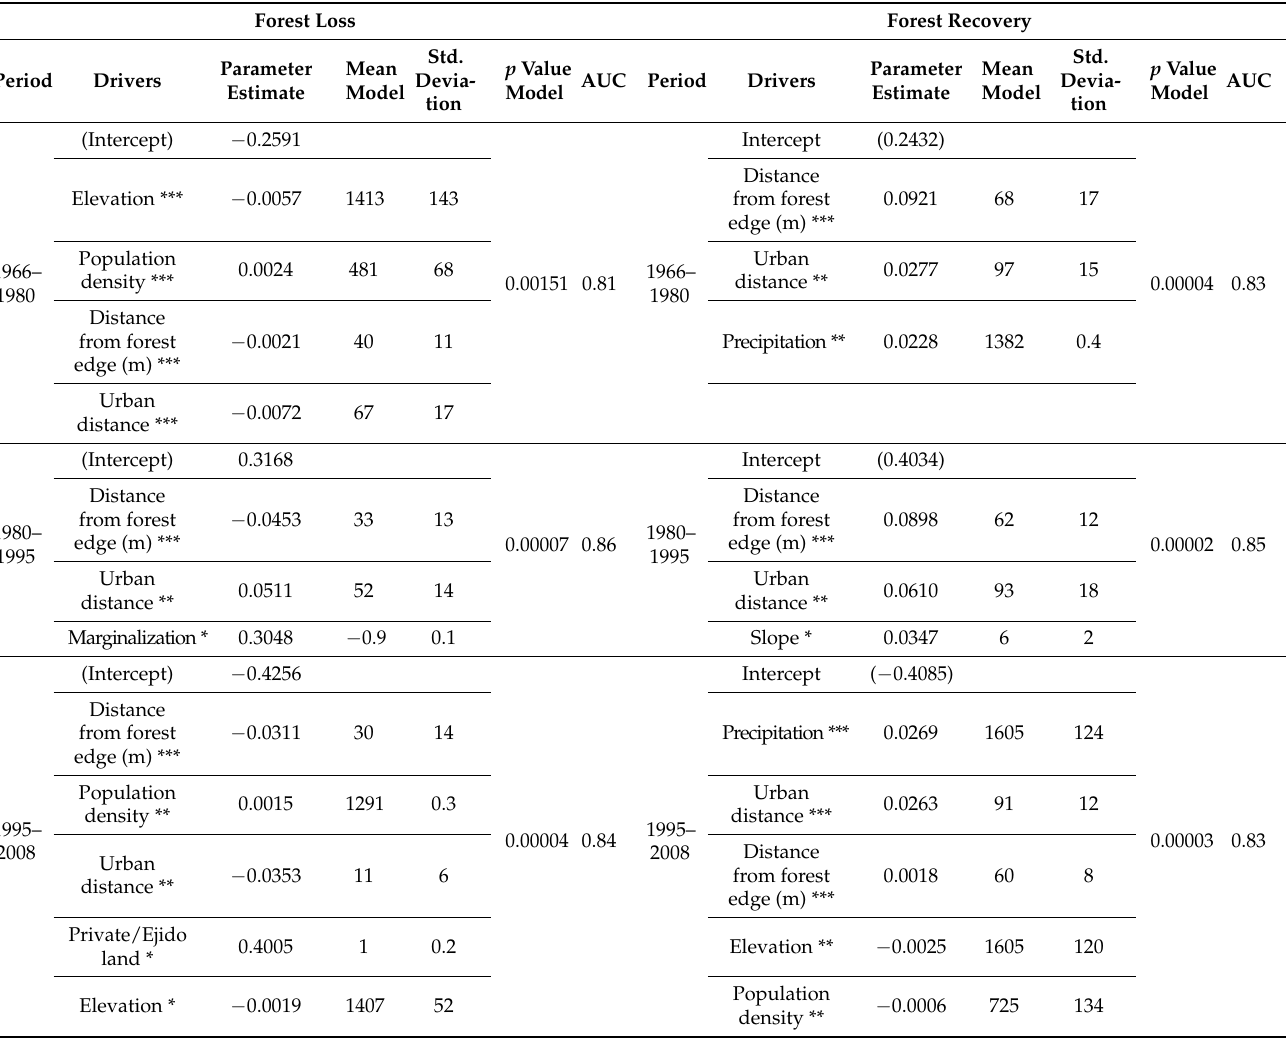
Table 3. Variables best-explaining the patterns of forest loss and forest recovery in stepwise logistic regression models run for the study area during different evaluation periods. Variables are presented in order of importance (according to significance level), together with the type and strength of correlation; also reported are the overall significance levels of the final stepwise logistic regression models and their explanatory power